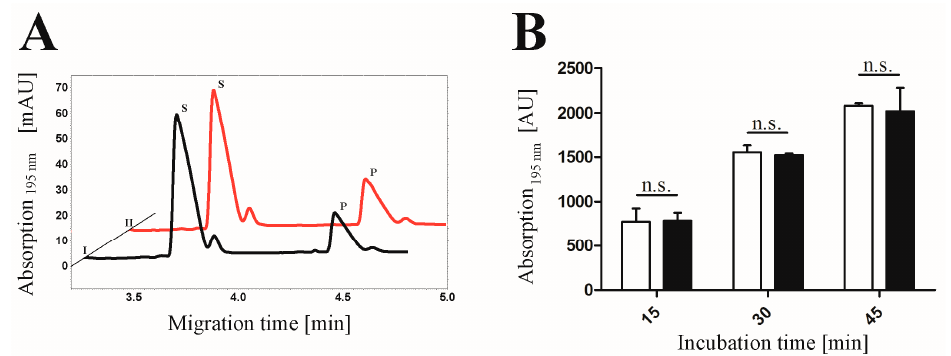
Figure 7. Phosphorylation activity of the heterotetrameric CK2 with or without coupling to DBCO545. ( A ) Comparison of the phosphorylated product between the holoenzyme including CK2 α -DBCO545 (I, 2.6 µg) and CK2 α -pAzF (II, 2.6 µg) is shown in an electropherogram after 30 min incubation with the substrate RRRDDDSDDD. Substrate (S) and product (P) peaks were detected after 3.7 min and 4.3 min, respectively. ( B ) The activities of the holoenzymes consisting of CK2 α -pAzF [ □ ] as well as CK2 α -DBCO545 [ ■ ] were analyzed after 15, 30 and 45 min for each sample by CE. Mean values ± standard errors of the means (SEM) from three independent experiments are given (not significant, p > 0.05).